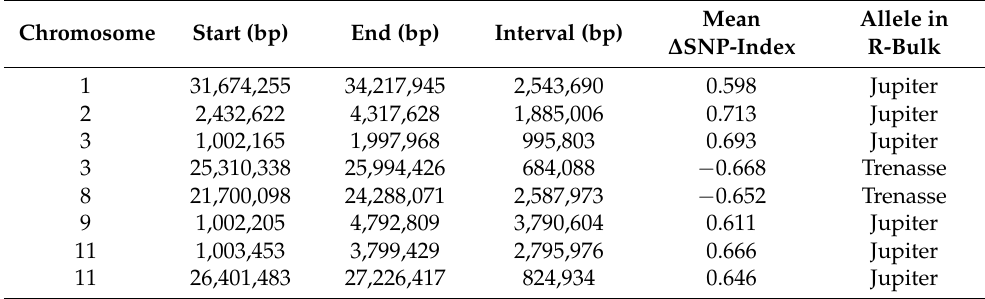
Table 7. Candidate genes related to plant defense, signaling, and flowering revealed by QTL-seq analysis.